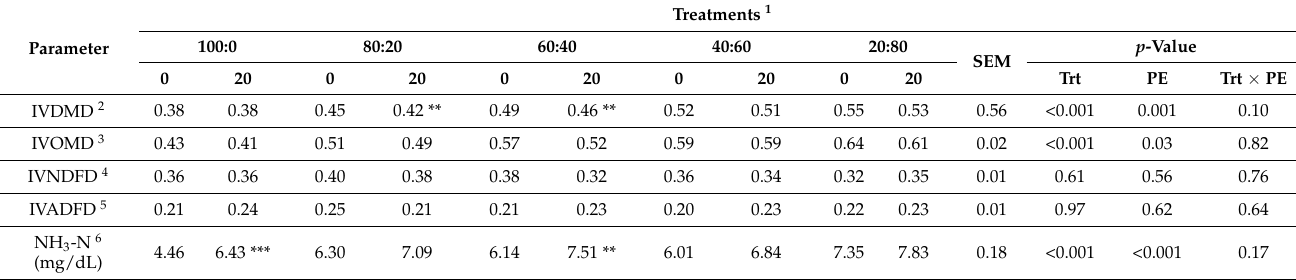
Table 4. Effect of plant-bioactives extract (PE) supplementation on digestibility and ammonia-nitrogen in different feeding styles after 24 h In Vitro incubation ( n =